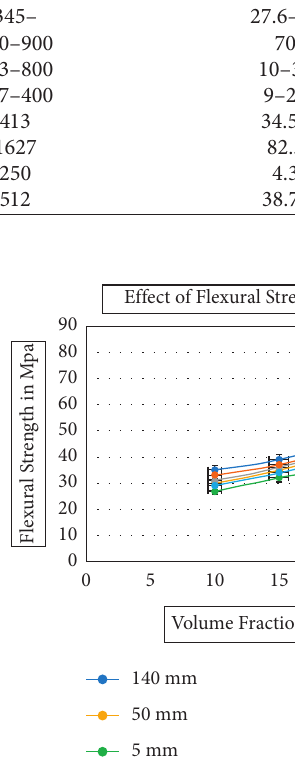
Figure 3: The relationship between flexural strength and the volume fraction of AAM fiber is explored through the use of different fiber